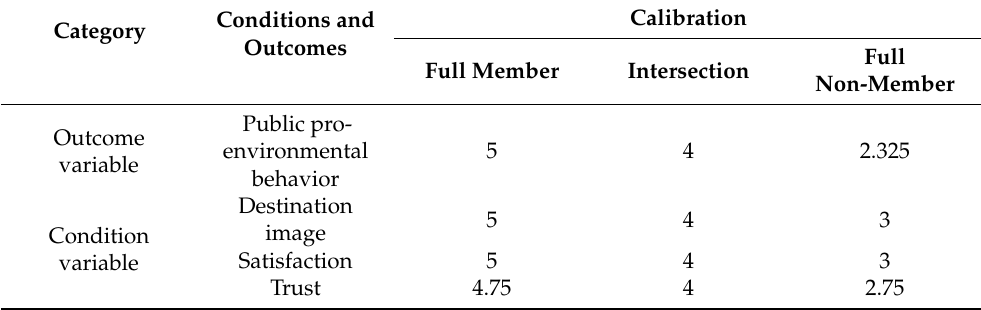
Table 15. Calibration of conditions and outcomes in the public pro-environmental